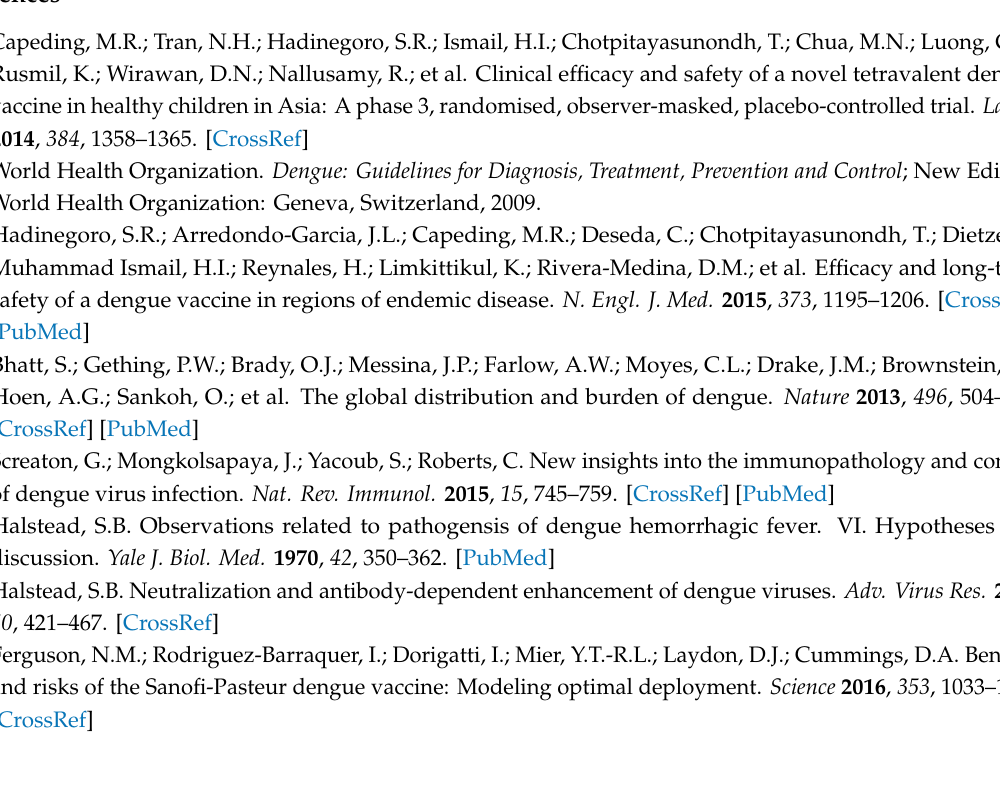
Figure S1: ADE by Ab treatment in U937 cells, Figure S2: DENV infection in monocytes, Figure S3: the levels of TNF and IL-6 in